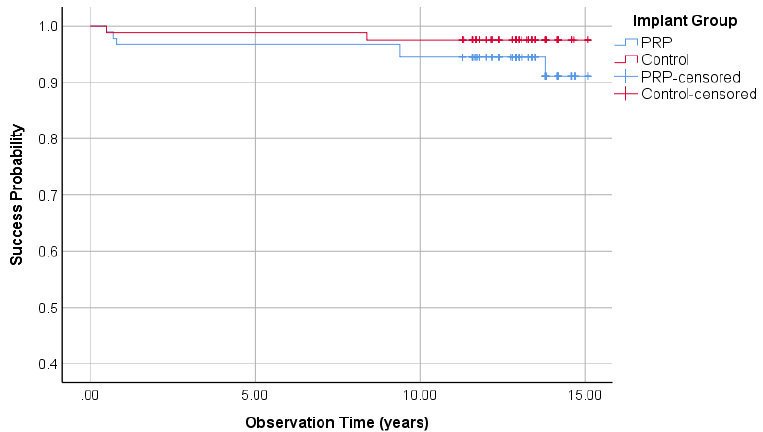
Figure 6. Kaplan–Meier success probabilities of 171 implants regarding the Buser implant success criteria in the split-mouth evaluation.